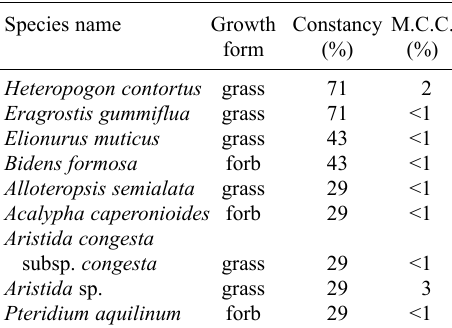
Diagnostic species of the Heteropogon contortus- Cyperus longus var . tenuiflorus